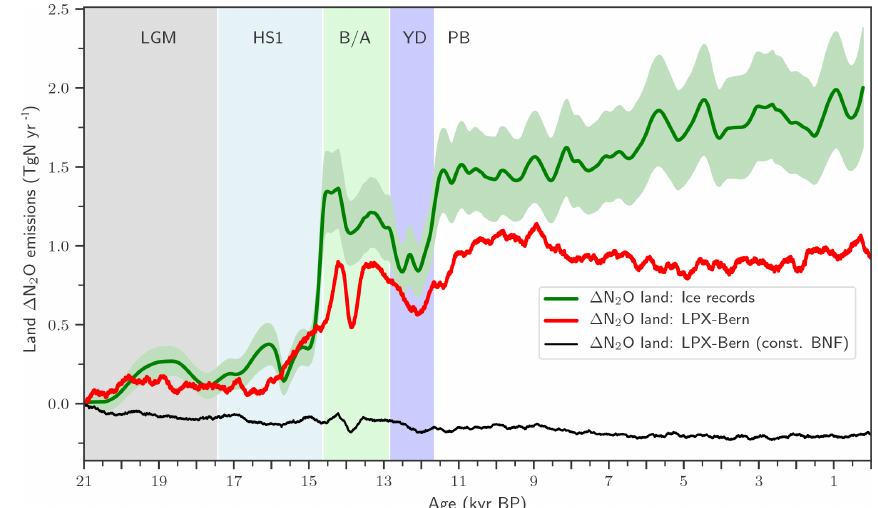
Figure 3. Changes in global terrestrial emissions of N 2 O. Reconstructed changes in global land N 2 O emissions are shown by the solid green line together with an uncertainty estimate ( ± 1 standard deviation; shaded area). Reconstructed changes are calculated with an atmospheric two-box model (Schilt et al., 2014) from ice records of N 2 O concentration and δ 15 N(N 2 O). Reconstructed changes are compared to LPX- Bern(v1.4N) for the baseline simulation (red line) and a simulation with biological nitrogen fixation kept constant at Last Glacial Maximum values (thin black